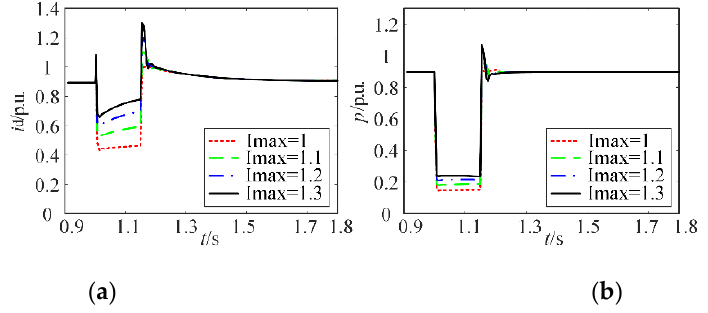
Figure 11. Simulation results in cases (5)–(8) of the fault of Bus8: ( a ) active current; ( b ) active output. Table 5. Active power index in cases (1)–(8) of the fault of Bus8.